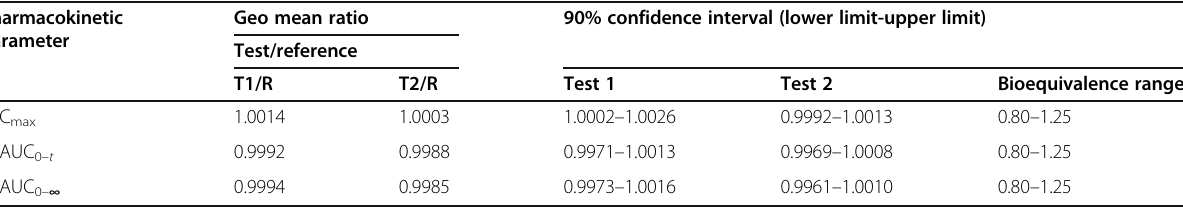
Table 3 90% confidence intervals of LnC max , LnAUC 0 – t , and LnAUC 0 – ∞ from the test formulations to the reference